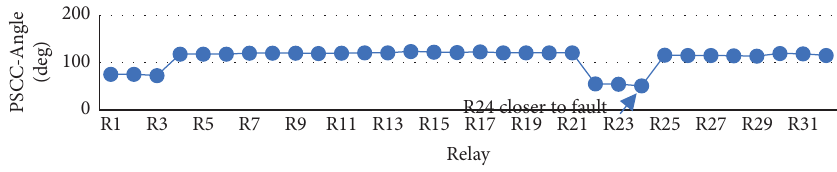
Figure 12: PCSS angle values when LLLG fault occurs on S24 (case 1).